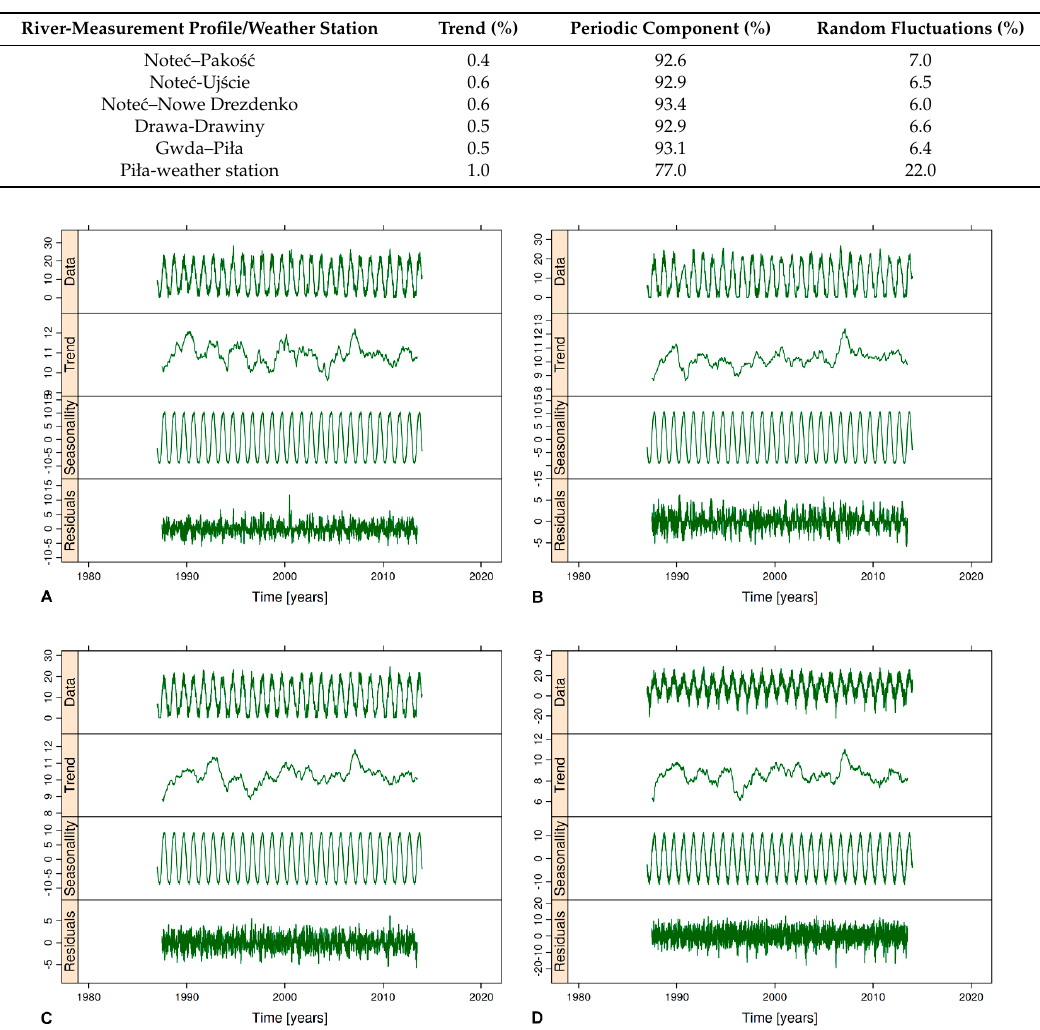
Figure 7. The trend, periodical fluctuations and random fluctuations in water and air temperature time series (1987–2013): Note ć -Pako ść ( A ), Note ć -Uj ś cie ( B ), Note ć -Nowe Drezdenko ( C ) and Pi ł a-air temperature ( D ).